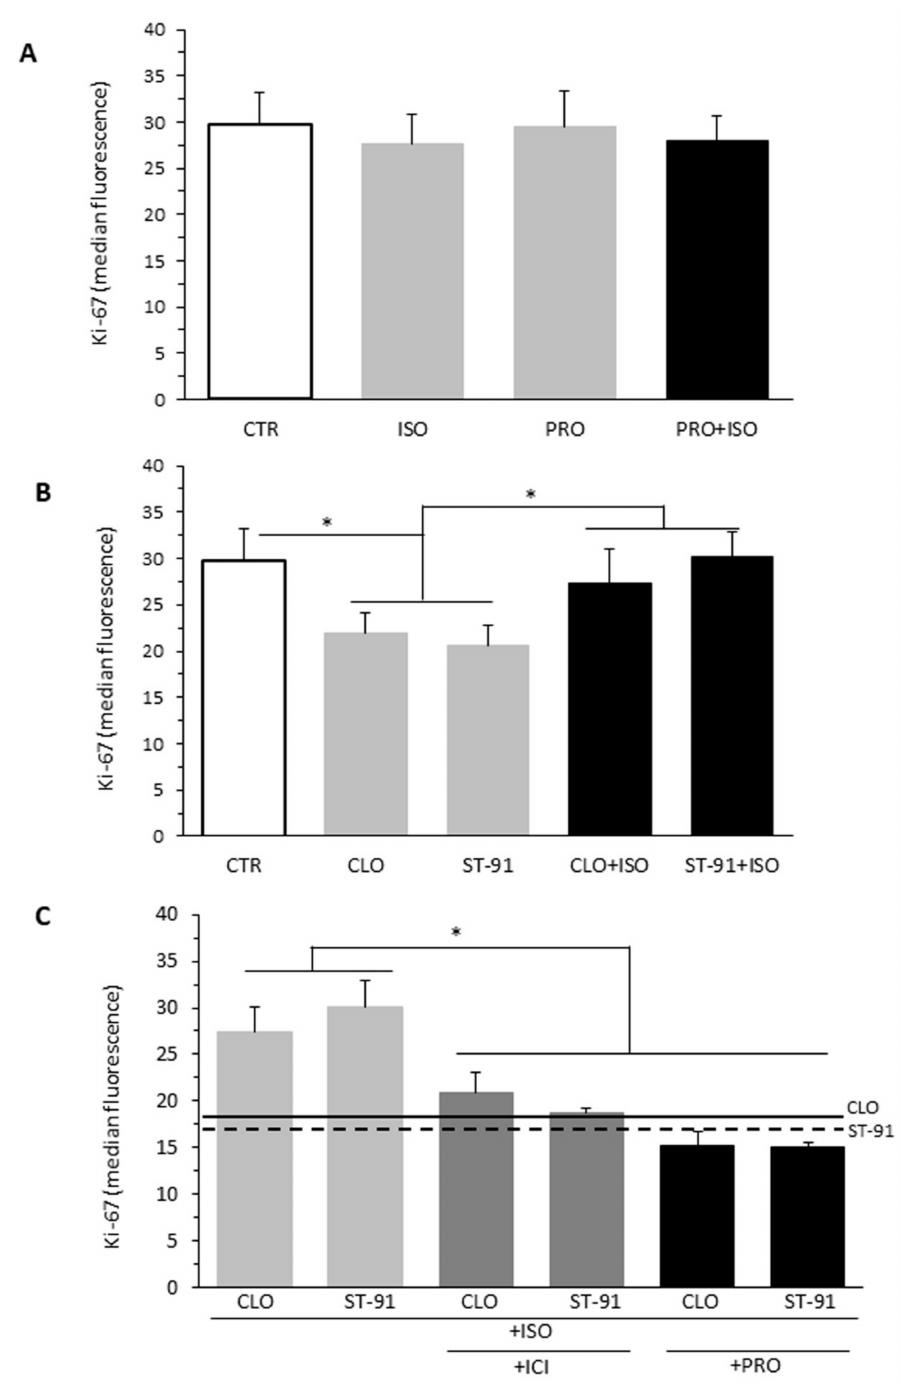
Figure 3. Effect of β -AR agonists on α 2-agonists-induced cell proliferation inhibition. Flow cytometry evaluation of cell proliferation performed by measuring Ki-67 nuclear antigen expression in B16F10 cells in different experimental conditions. ( A ) Cells untreated (CTR) or treated with isoproterenol (ISO, 1 µ M), propranolol (PRO, 10 µ M), or ISO plus PRO for 48 h. ( B ) Cells untreated (CTR) or treated with clonidine (CLO, 1 µ M) or ST-91 (1 µ M) alone or in combination with isoproterenol (ISO, 1 µ M). ( C ) Cells treated with CLO (1 µ M) plus ISO (1 µ M) or ST-91 (1 µ M) plus ISO (1 µ M) in the presence or the absence of ICI (1 µ M), a selective β 2-AR antagonist, or PRO (1 µ M), a non-selective β -blocker. Data from four independent experiments are reported. On the ordinate y-axis, the median fluorescence intensity values are reported. Solid and dashed lines indicate the proliferation values in cells treated with CLO or ST-91 alone, respectively. * p <